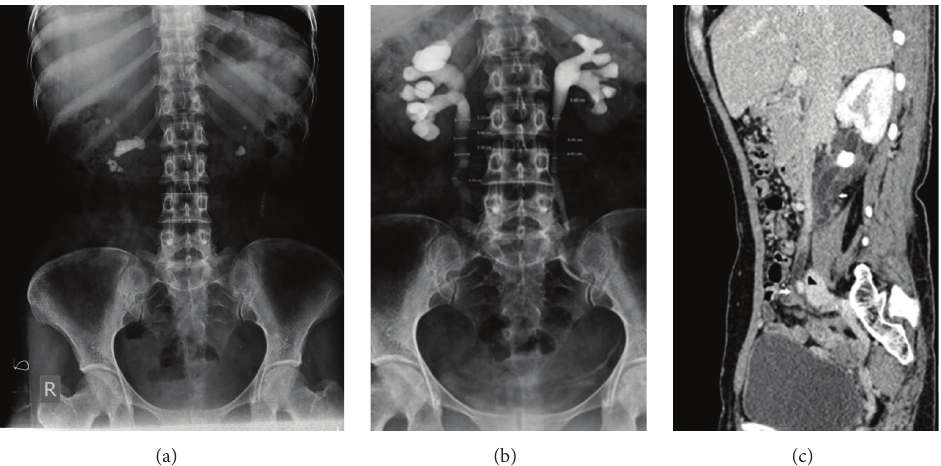
Figure 3: (a) Scout film: bilateral renal calculi. (b) IVU: a dilated right ureter, but the cause was not apparent. No ureteral calculus on noncontrast CT. (c) Contrast-enhanced CT scan: marked wall thickening in the region of ureteral dilatation (arrow) indicating ureteritis and also an extrinsic vascular compression of the right ureter (between arrowhead and lower white